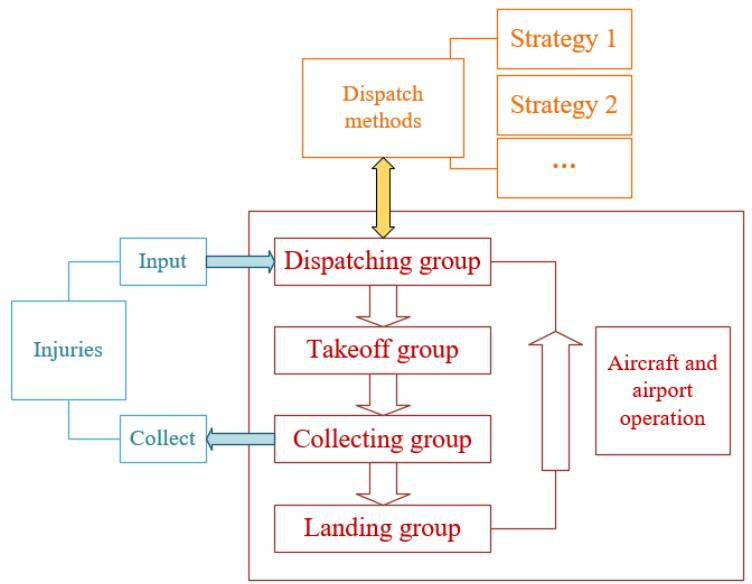
Figure 7. Framework of